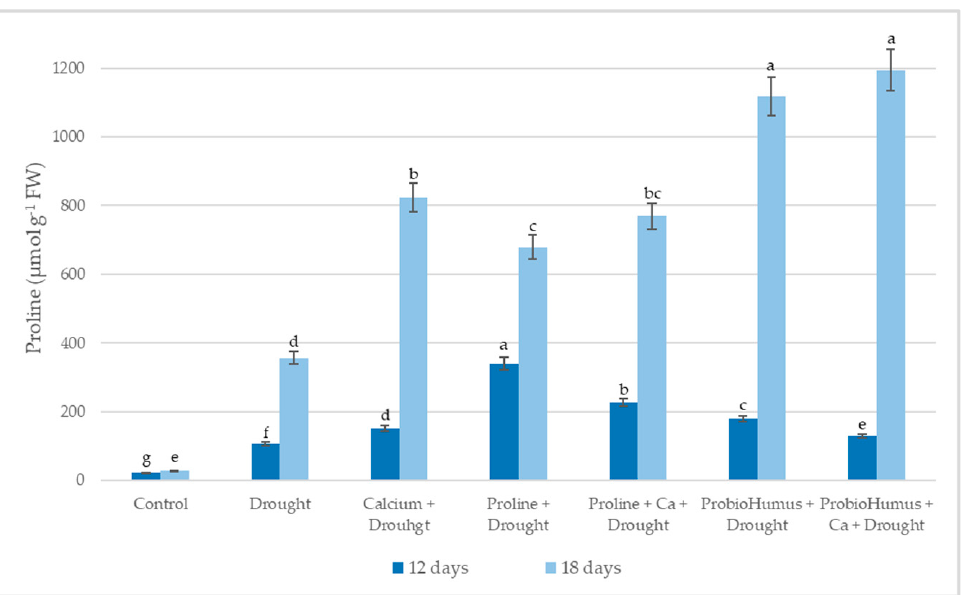
Figure 3. The effect of stress-protecting compounds application and prolonged drought stress (12, and 18 days), on winter wheat proline accumulation. Error bars represent the standard deviation of the mean. Control, Ca, proline, proline + Ca, ProbioHumus, and ProbioHumus + Ca indicates the type of application. Different lowercase letters in the same day of drought indicate statistically significant differences ( p < 0.05).